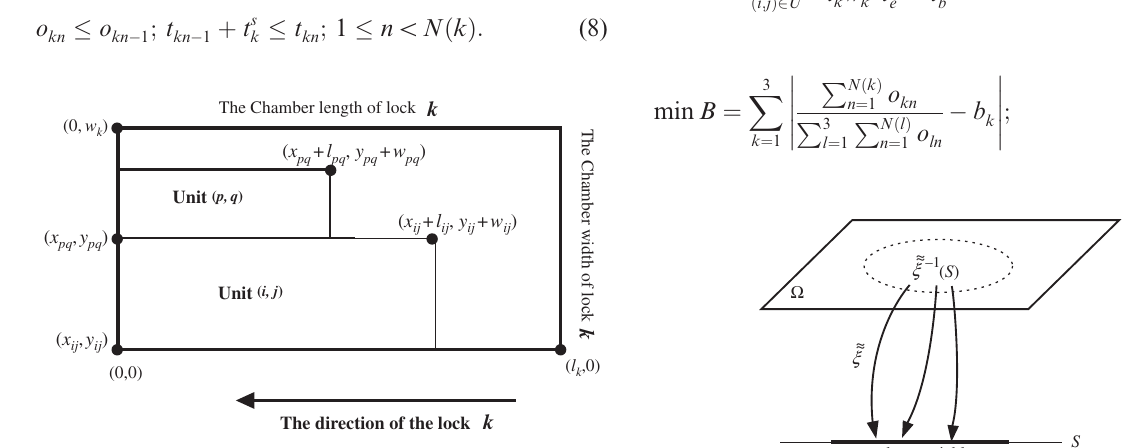
random variables Fig. 6. Birandom